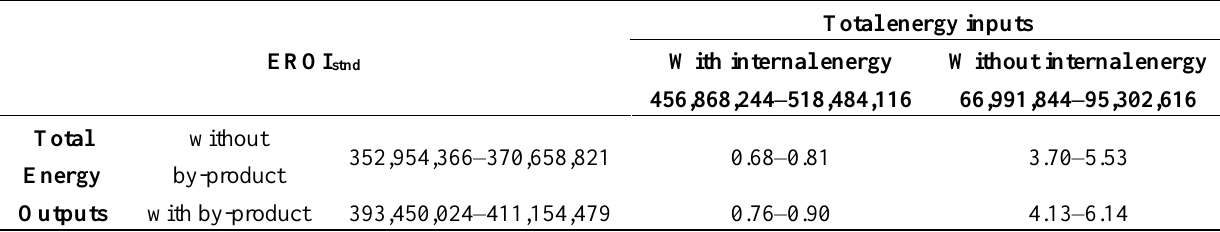
Table 5. EROI stnd of the Shenhua DCL project.